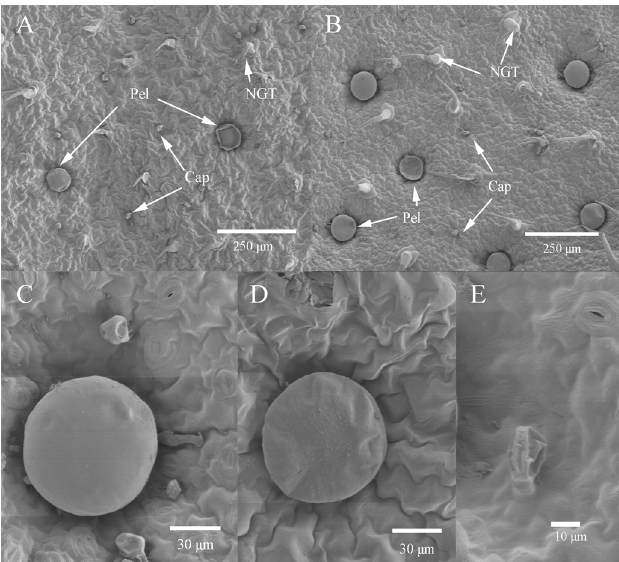
Figure 3. SEM (scanning electron microscope) micrographs showing the distribution and types of S. tenuifolia trichomes. ( A ) Adaxial leaf surface exhibiting three types of trichomes: non-glandular trichome (NGT), peltate glandular trichome (Pel) and capitate glandular trichome (Cap); ( B ) Abaxial leaf surface; ( C ) Peltate and capitate glandular trichomes on the leaf abaxial side; ( D ) Mature peltate glandular trichome; ( E ) Wrinkled capitate glandular trichome.